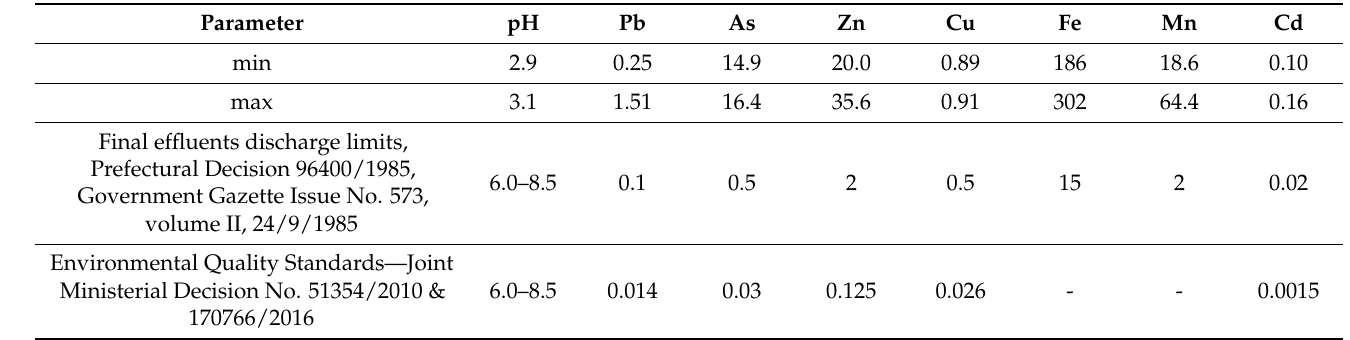
Table 4. Chemical analysis of run-off water from the old arsenopyrites concentrate storage area (mg/L).